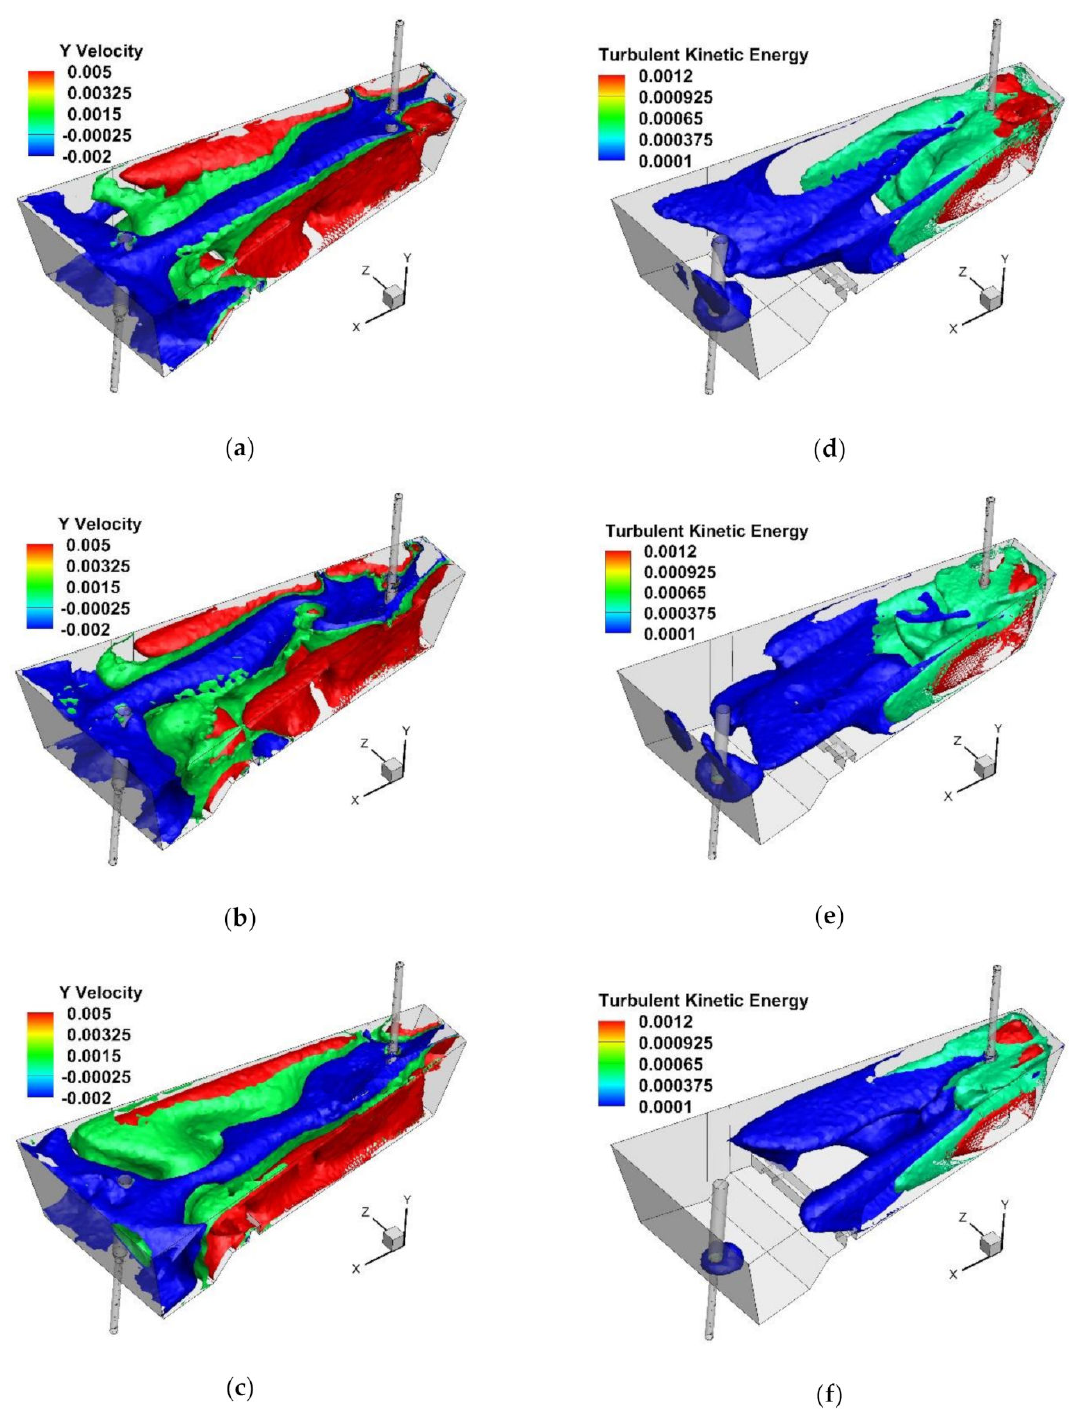
Figure 11. Y component velocity (m/s) and turbulent kinetic energy (m 2 /s 2 ): ( a , d ) tundish with SFC No. 3C105, ( b , e ) tundish with SFC No. 3C125, ( c , f ) tundish with SFC No.